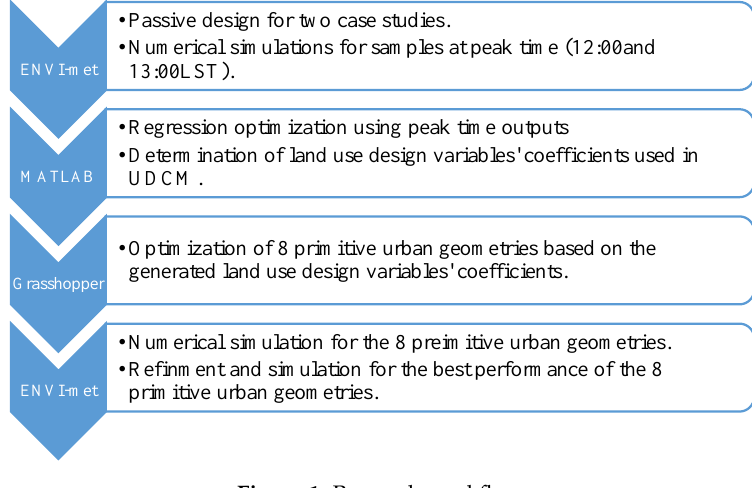
Figure 1. Research workflow.